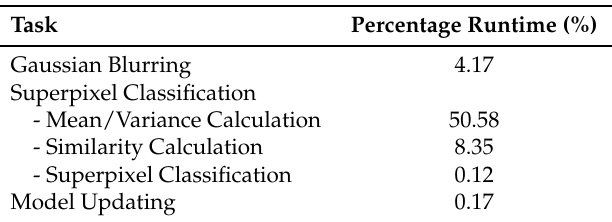
Table 2. Runtime Analysis of SuperBE.